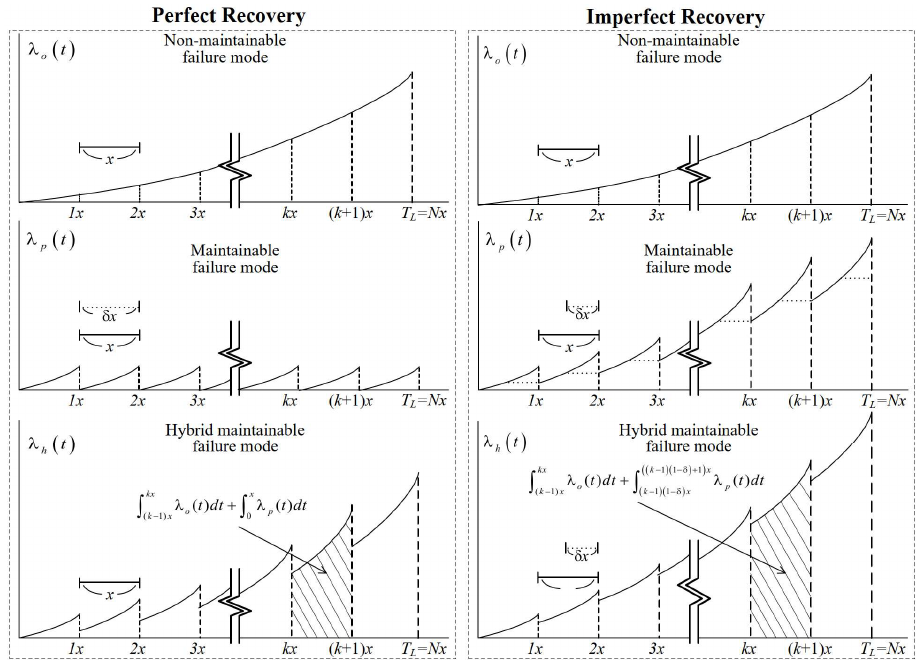
Figure 2. Preventive maintenances between perfect recovery and imperfect recovery under a hybrid deterioration.